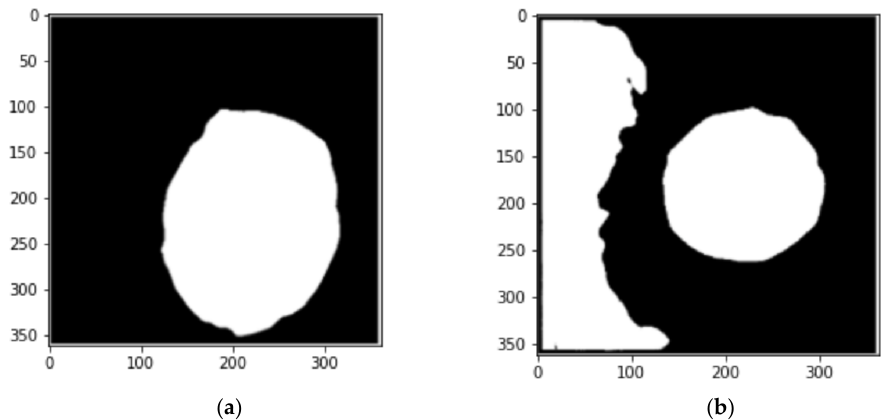
Figure 10. Illustration of ( a ) the segmented optic disc is presented as a binary image. The white part is the optic disc while the black is the background and ( b ) the part on the side of the image is the artifacts included in the segmentation process yielding an incorrect representation of the optic disc.